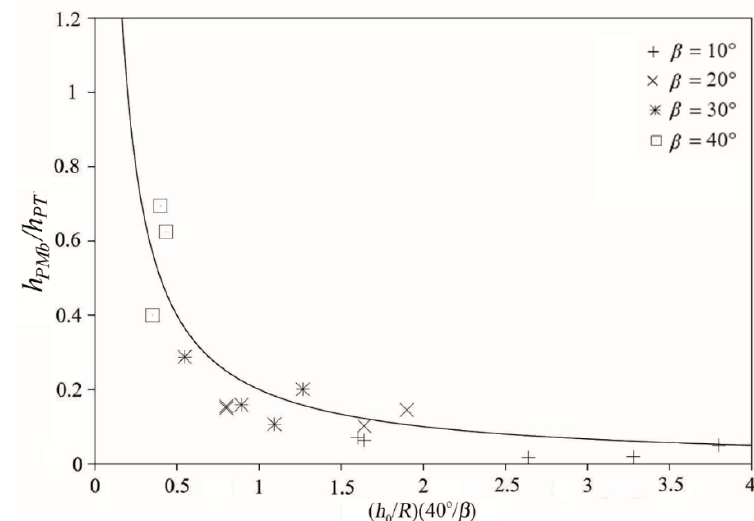
Figure 2. Behavior of the dynamic pressure head on bucket centerline: (—) ratio between the maximum calculated and the theoretical pressure heads from Equation (12) versus the ratio between the maximum calculated and the theoretical pressure head from the present study (symbols).